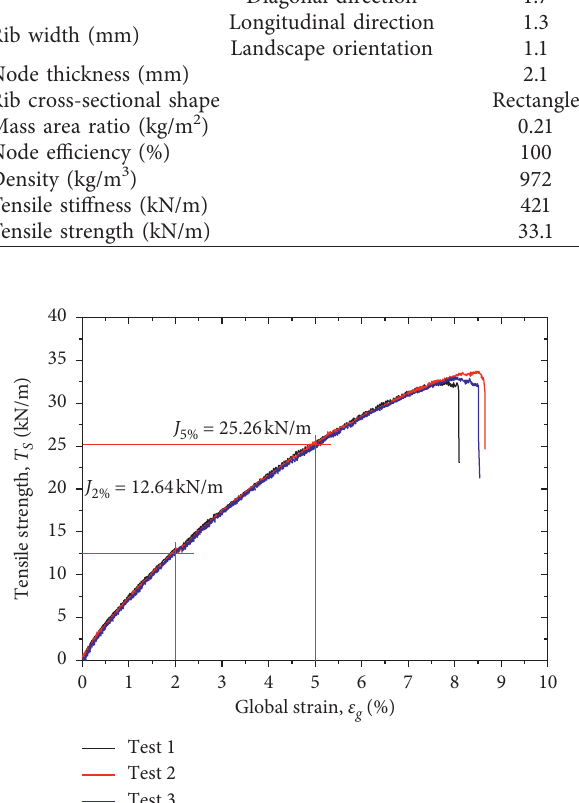
Figure 3: Single-rib tensile tests for the